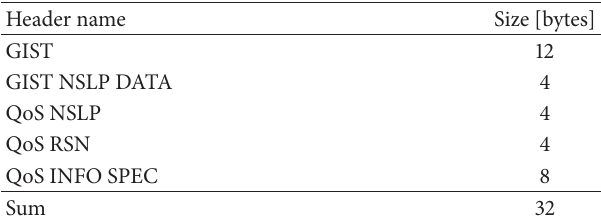
Table 4: QoSiLAN request header sizes. Table 5: QoSiLAN response header